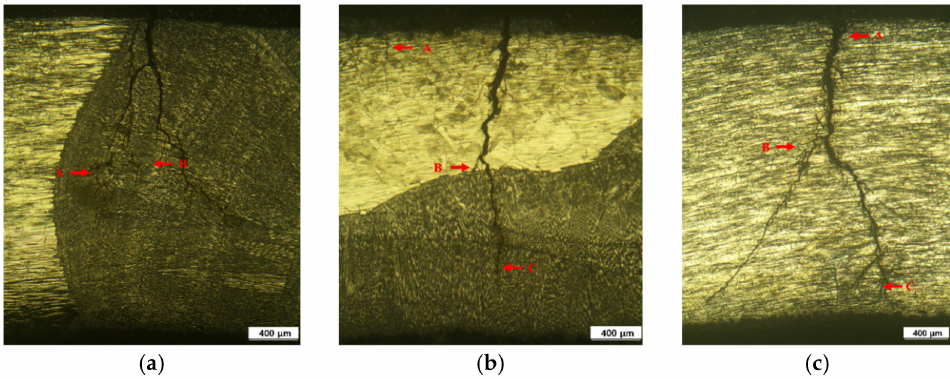
Figure 9. Photographs of the cross section of 304LW after U-bend SCC test (OM, × 50, 155 ◦ C, 42% MgCl 2 ): ( a ) 304LW; ( b ) 304LW − L − NC; ( c ) 304LW − L −